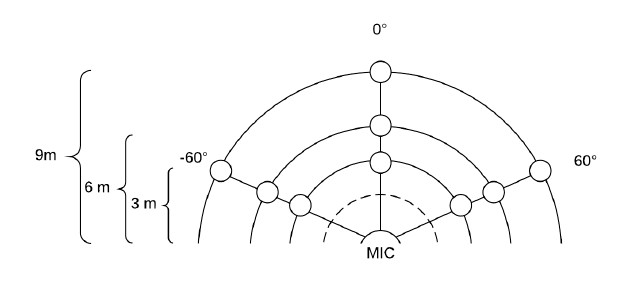
Figure 2. Diagram for data collection points spatial distribution.